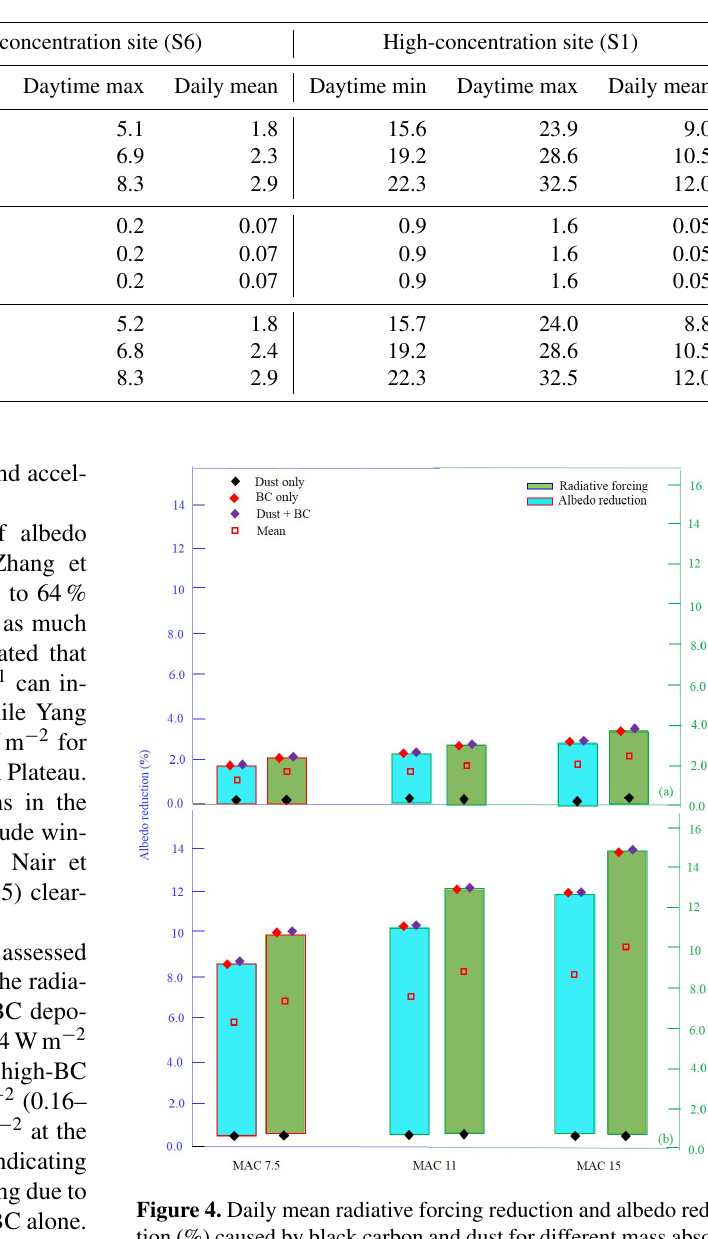
Figure 4. Daily mean radiative forcing reduction and albedo reduc- tion (%) caused by black carbon and dust for different mass absorp- tion cross-section values (MAC) in (a) fresh (low black carbon) and (b) aged (high black carbon) snow samples (note different scales of y